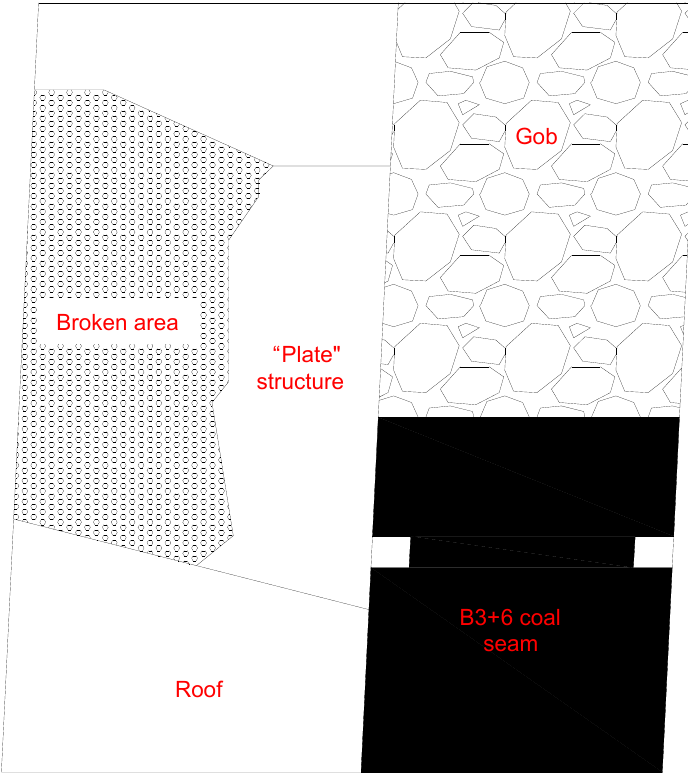
Figure 15. Schematic diagram of the “plate” structure produced by deep hole-blasting.